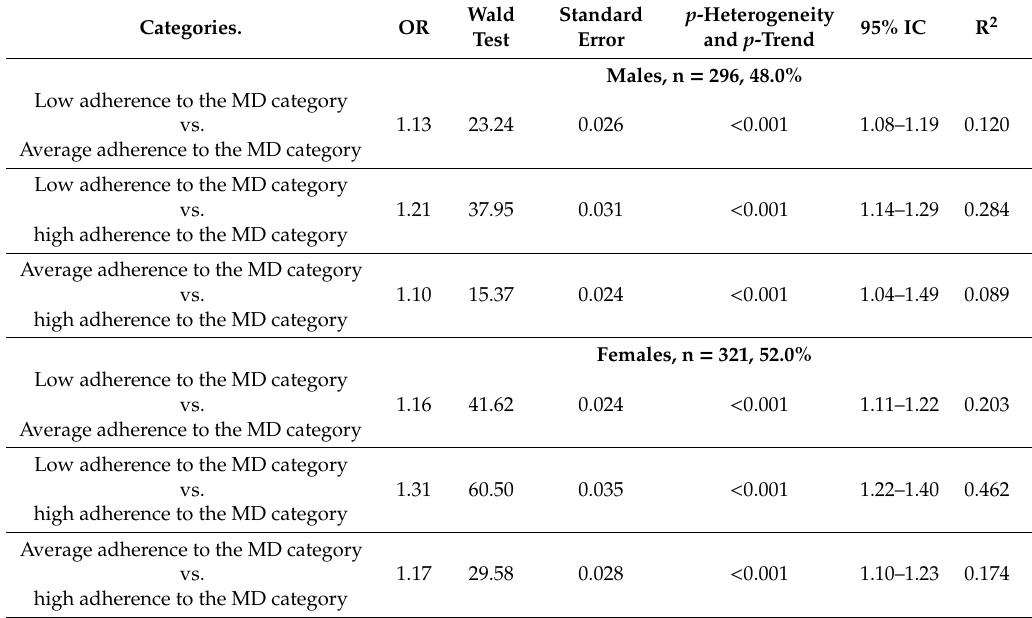
Table 5. Bivariate proportional odds ratio (OR) model to assess the association between 25OHD levels and PREDIMED